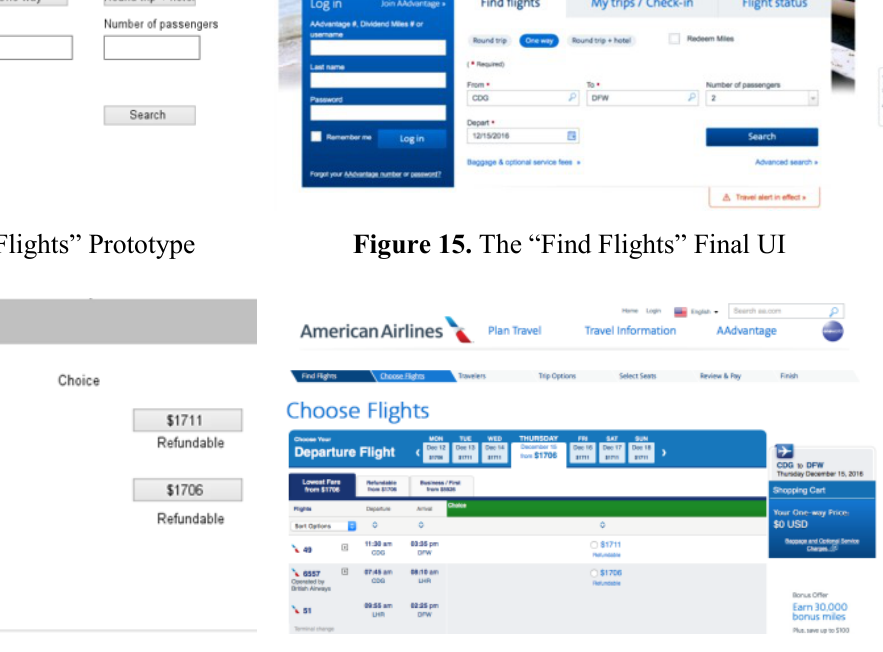
Figure 16. The “Choose Flights” Prototype Figure 17. The “Choose Flights” Final UI